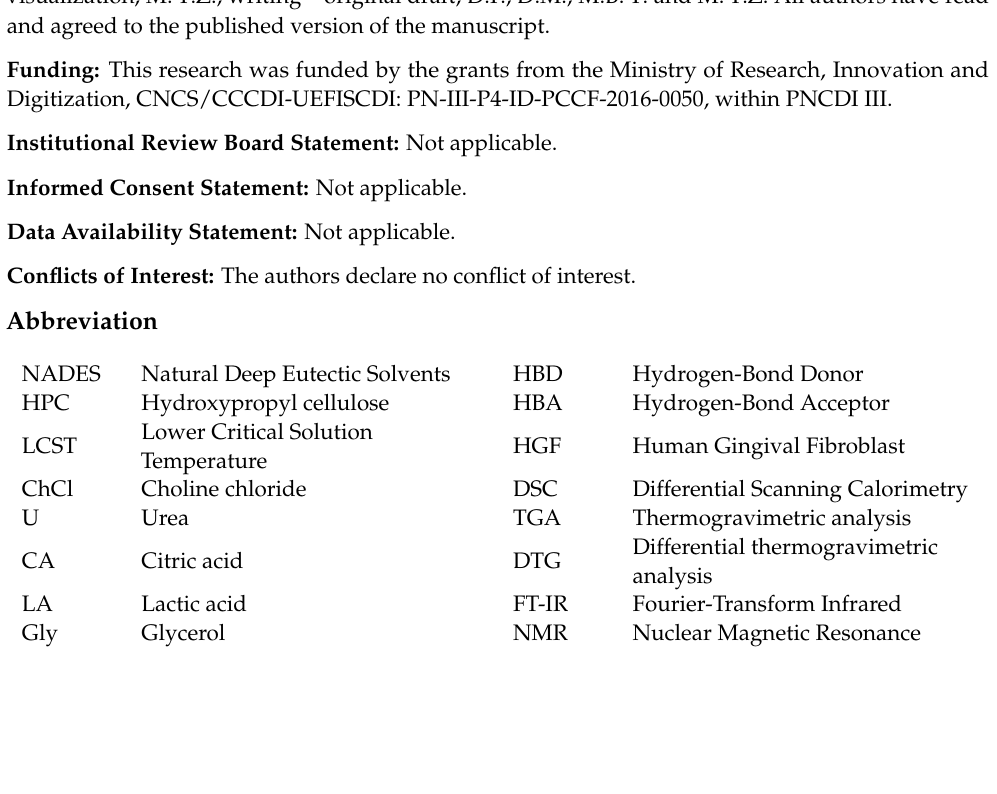
Figure S8. 2D ROESY spectrum of ChCl-CA-H 2 O (1:1:10 molar ratio); Figure S9. 2D ROESY spectrum of HPC-ChCl-U